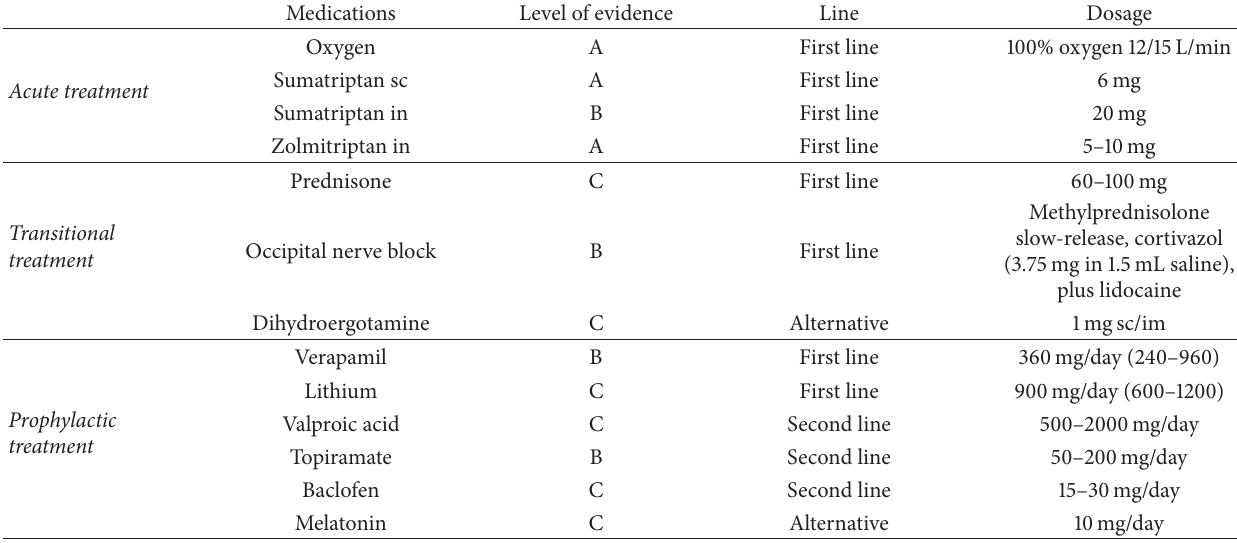
Table 1: Summary of treatment options in CH